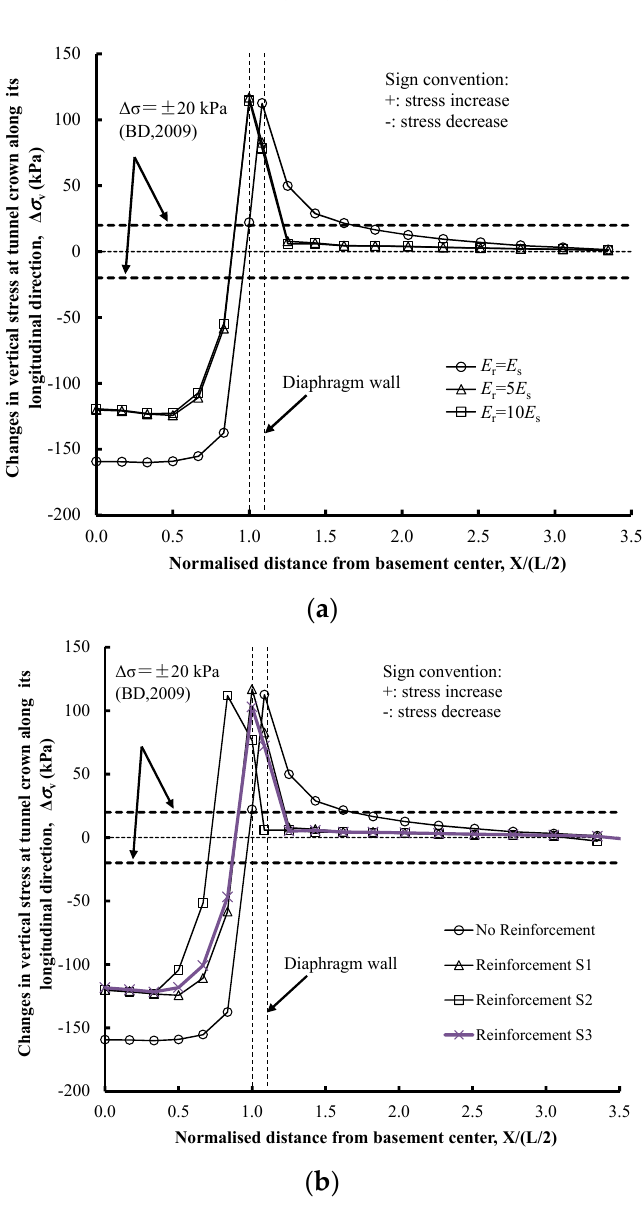
Figure 10. Computed vertical stress change in the soil element at the crown in the circumferential direction for ( a ) different reinforcement Young’s moduli and ( b ) different reinforcement depth.